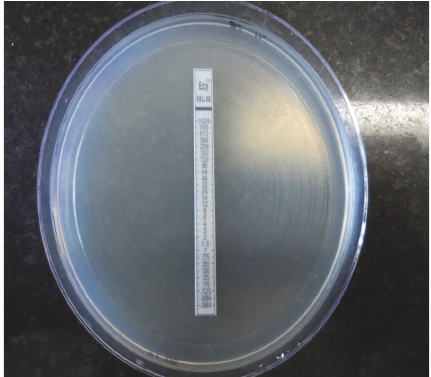
Figure 3: E-test showing MIC of gentamicin against resistant strain Enterococcus faecium (MIC > 1000 𝜇